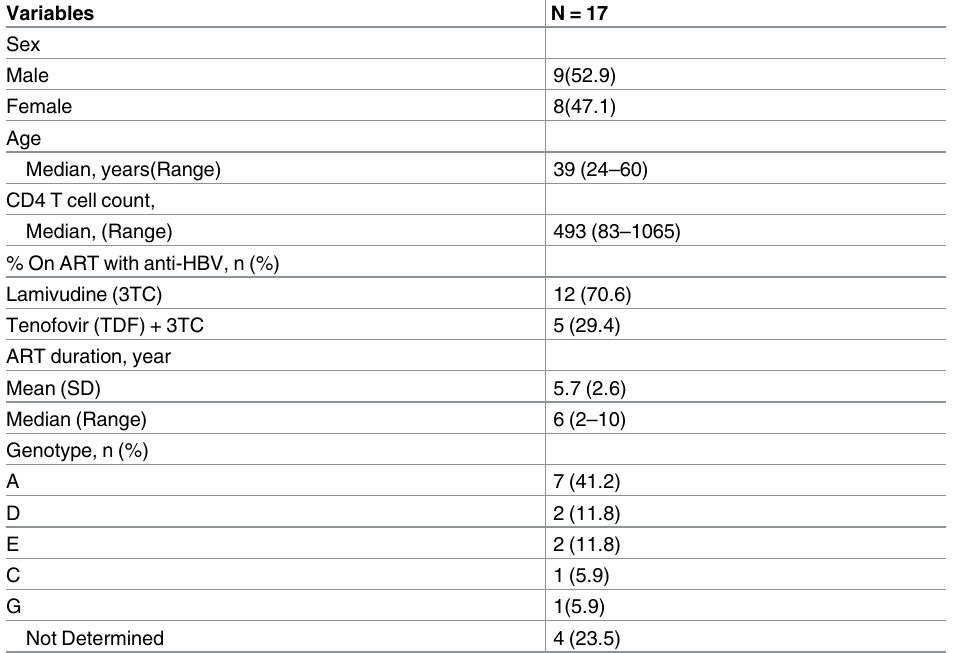
Table 3. Summary of clinical and demographic characteristics of the 17 HBV/HIV co-infected patients at the University of Gondar Hospital, March-July, 2016.